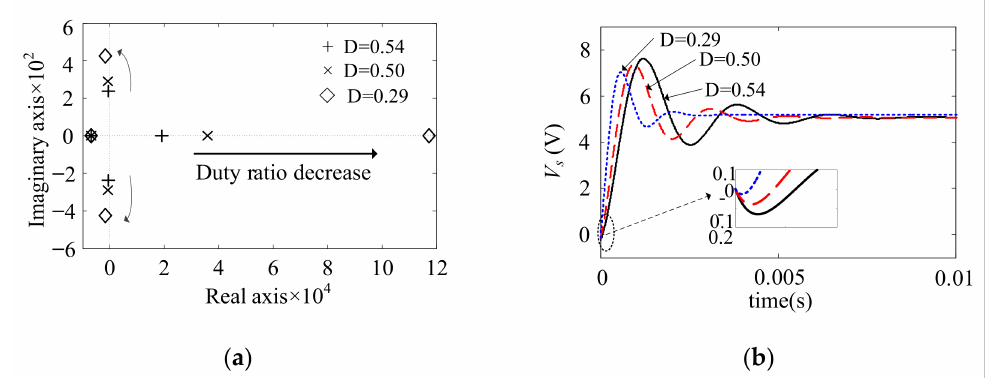
Figure 6. The influence of different input voltages on the system for the same load. ( a ) The position of zeros and poles. ( b ) Step response.